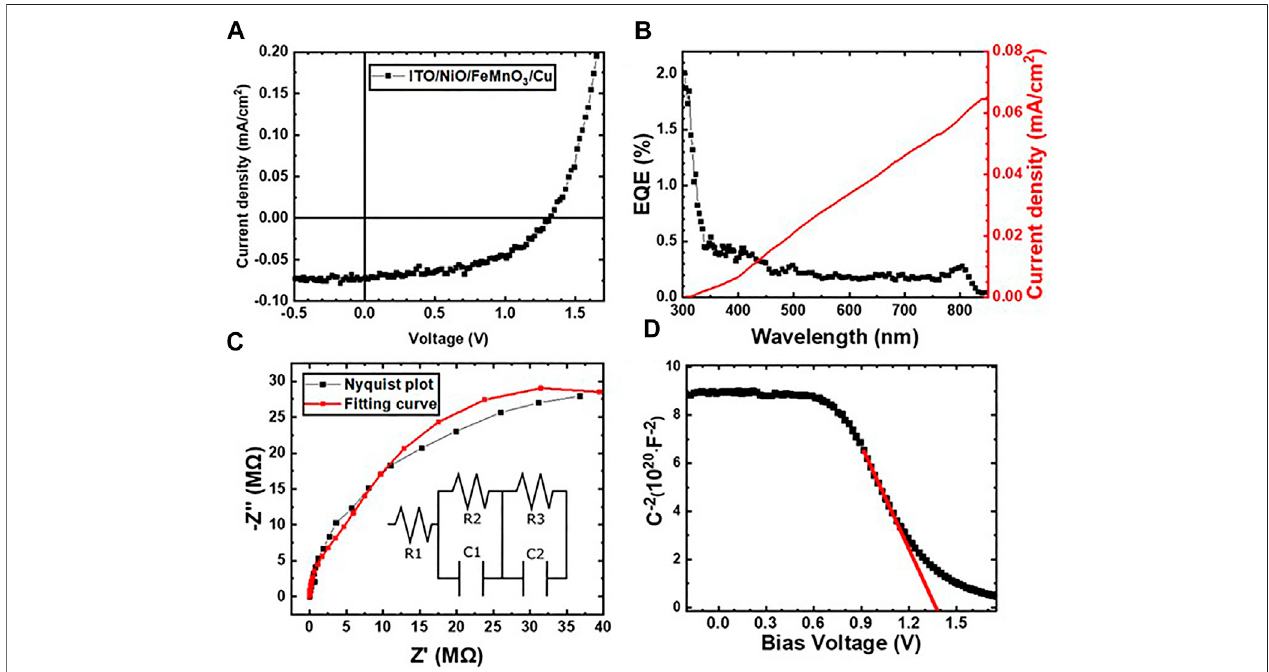
FIGURE 5 | (A) J-V plot under illumination conditions for the representative p-n device under this study ITO/NiO/FeMnO 3 /Cu. (B) EQE spectrum of NiO − FeMnO 3 (p – n)heterojunctionsandwichedbetweenITOandCuelectrodes.Therightaxisrepresentstheintegratedphotocurrentdensityofthecorrespondingdevice. (C) Nyquist, and (D) Mott – Schottky plots for the ITO/NiO/FeMnO 3 /Cu device.